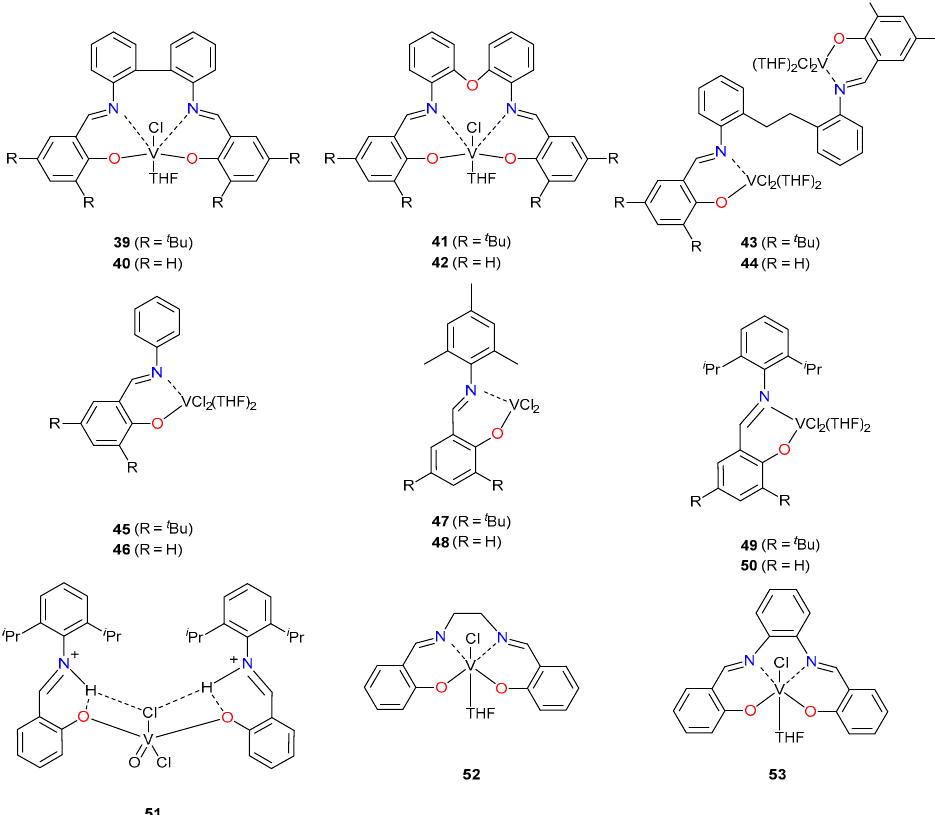
Figure 8. V(III) complexes 39–53 employed in the ROP of ε -caprolactone [47].